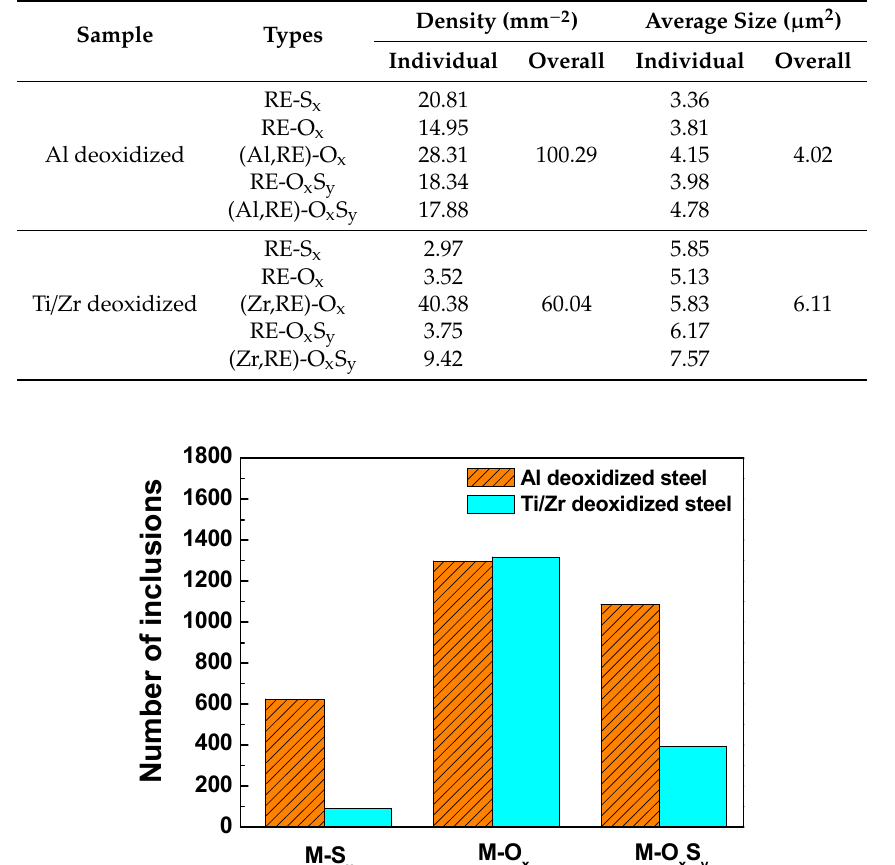
Table 3. Statistical distributions of inclusions in RE microalloyed steels.